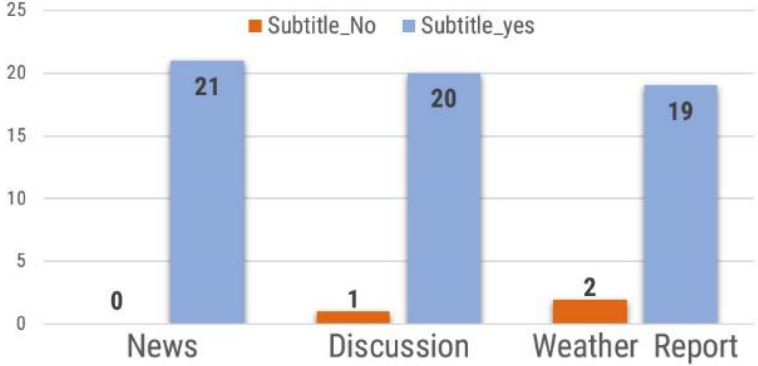
Figure 19. Results of experiments with subtitles. Table 9. Subjects’ opinions on the subtitles.